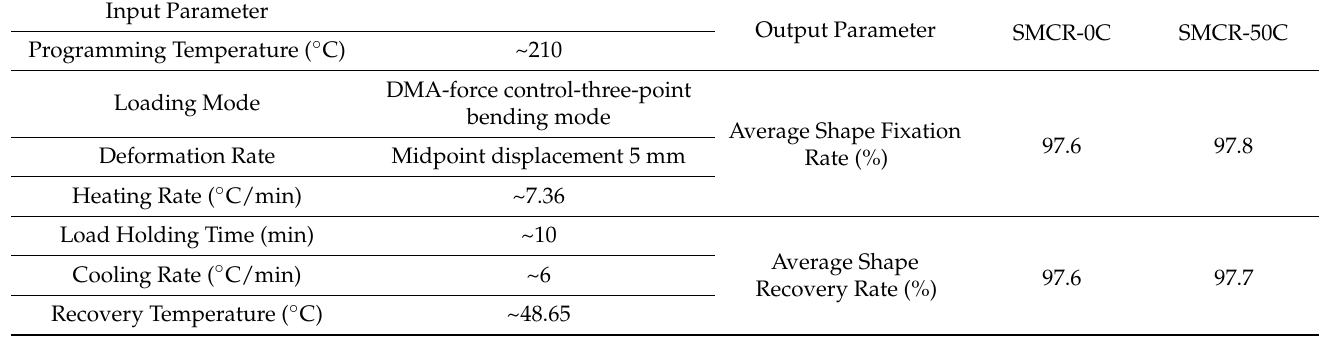
Table 1. Input and output parameters of the shape memory cycle.